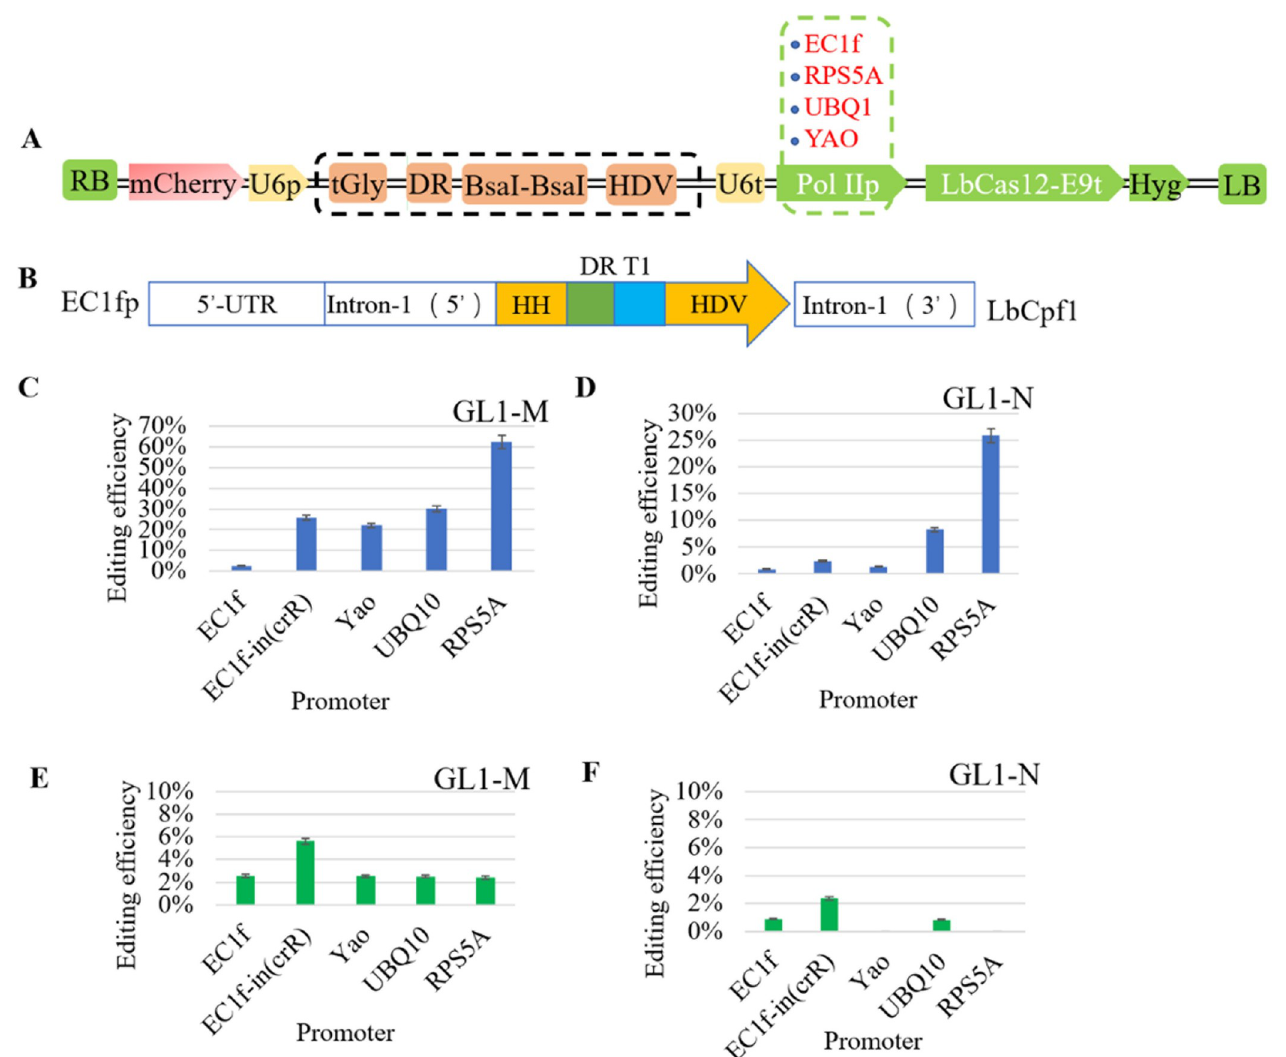
Fig 2. Editing efficiencies of CRISPR/LbCas12a driven by different promoters. (A) Schematic diagram of vector of the CRISPR/LbCas12a driven by different promoters. Green dotted line boxes includes the EC1fp, RPS5Ap, UBQ10p, and YAOp. (B) Schematic diagram of fusion promoter. (C) and (D) Editing efficiencies of different promoters in target GL1-M and GL1-N. (E) and (F) The rate of homozygous/bi-allelic mutants in target GL1-M and GL1-N.